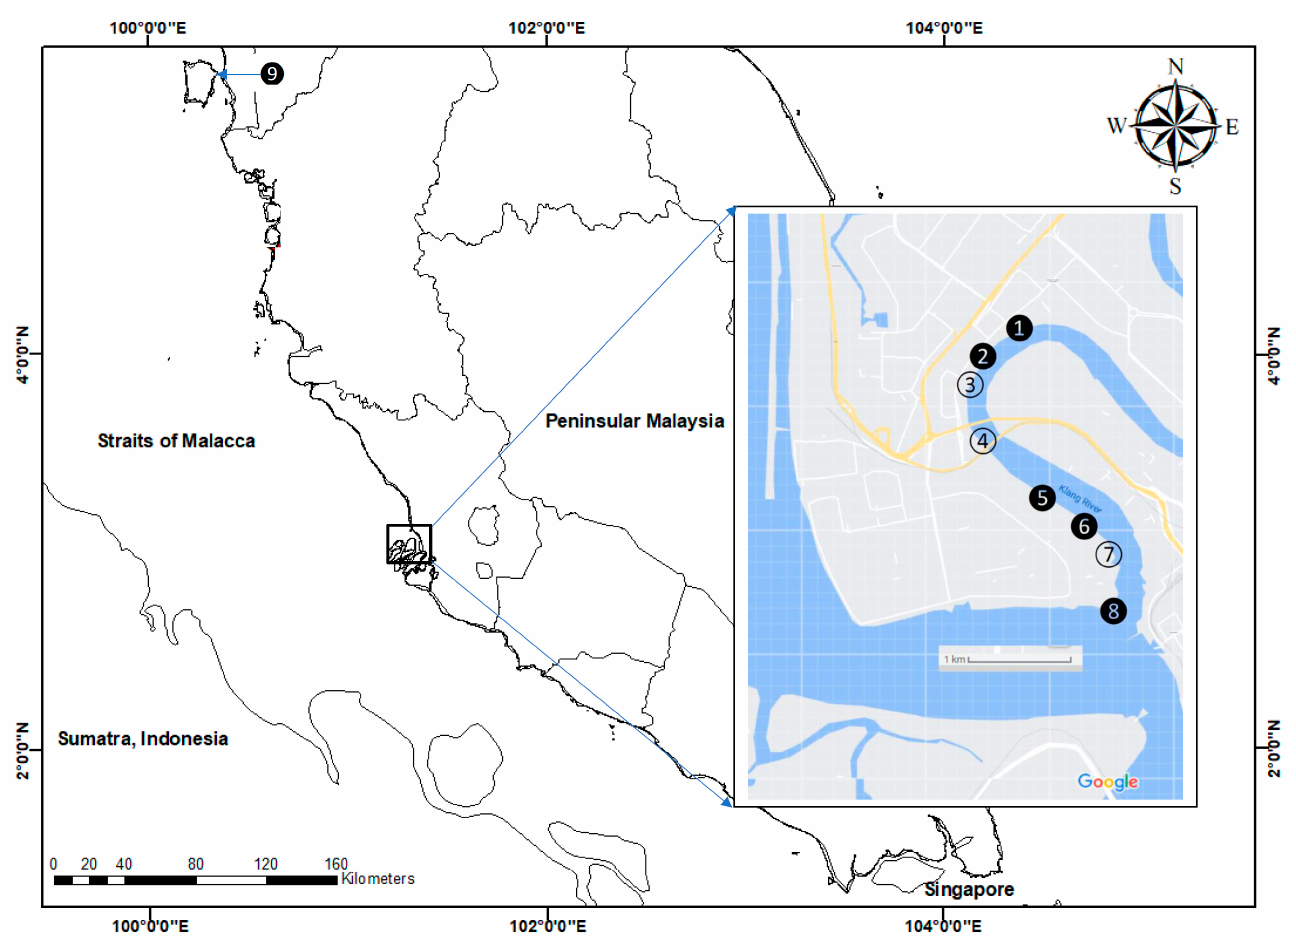
Figure 1. Sampling sites for surface sediments in the Klang mangrove ecosystem (S1–S8) and Juru mangrove ecosystem (S9) from the present study. Leaves of mangrove Avicennia were collected at the blacken circles (S1, S2, S5, S6, S8 and S9).